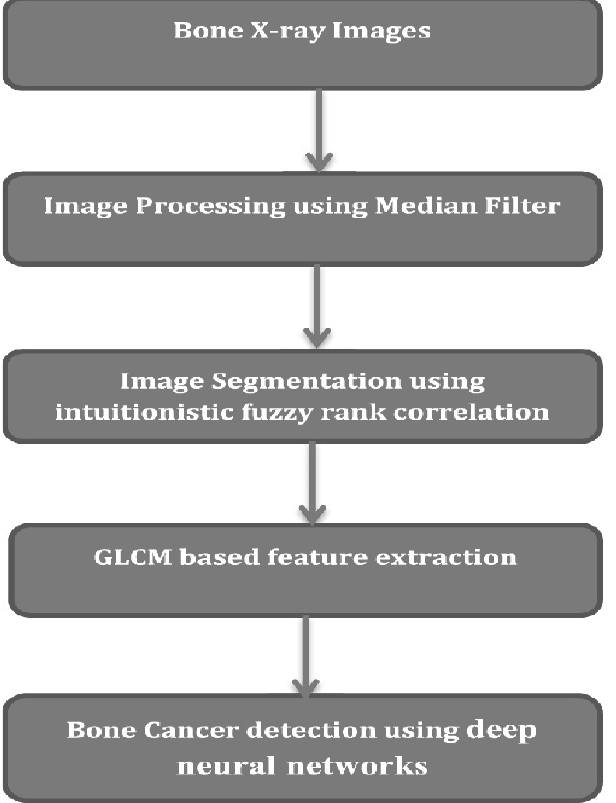
Figure 1. Spinal cord tumor classi fi cation model fl owchart.